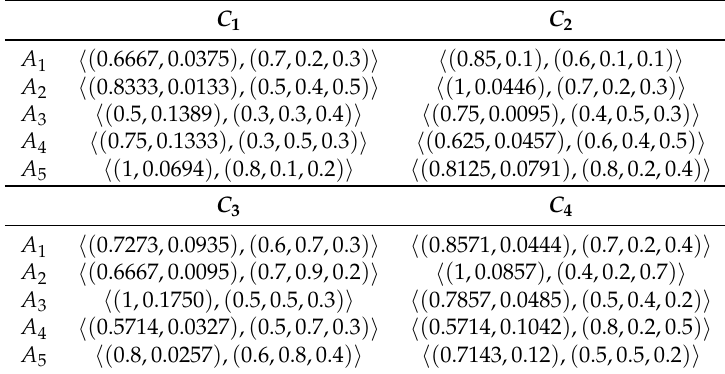
Table 4. Normalized decision matrix ˜ D .